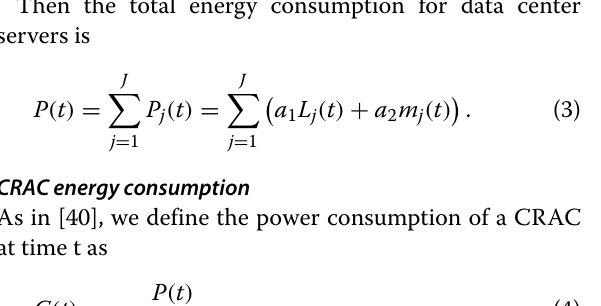
Fig. 2 Typical server design and modern rack design. a A typical server design: fans installed in servers. b Fan-equipped rack [43]: shared cooling fan wall on rack front